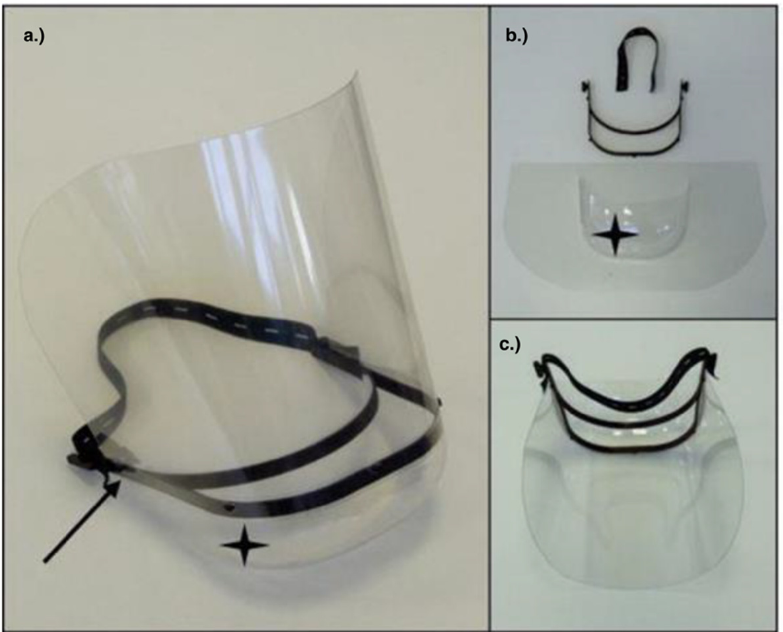
Figure 4. The 3D printed face shield. ( a ) Assembled face shield; ( b ) disassembled face shield with 3D printed face shield holder, plastic face shield and strap; ( c ) reverse look of assembled face shield.